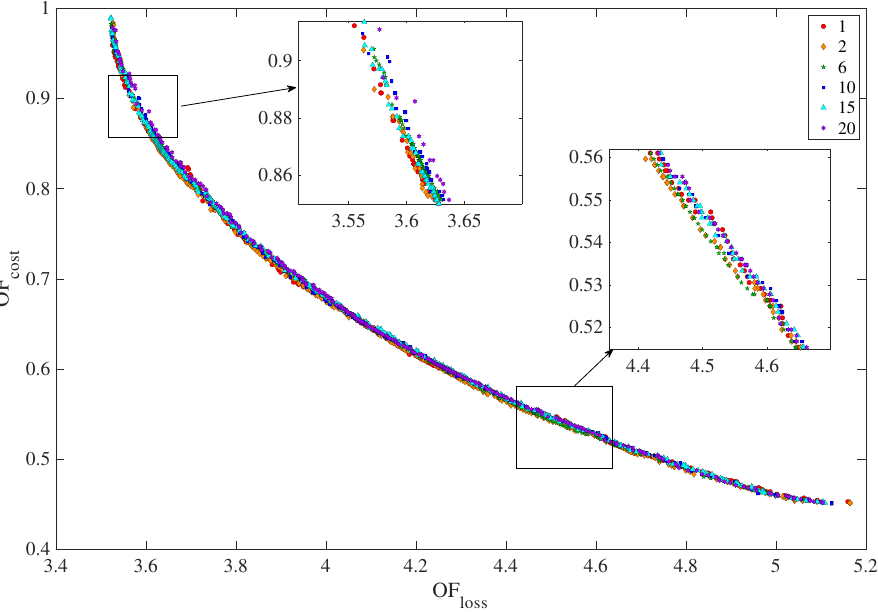
Figure 8. Non-dominated Pareto solutions for different